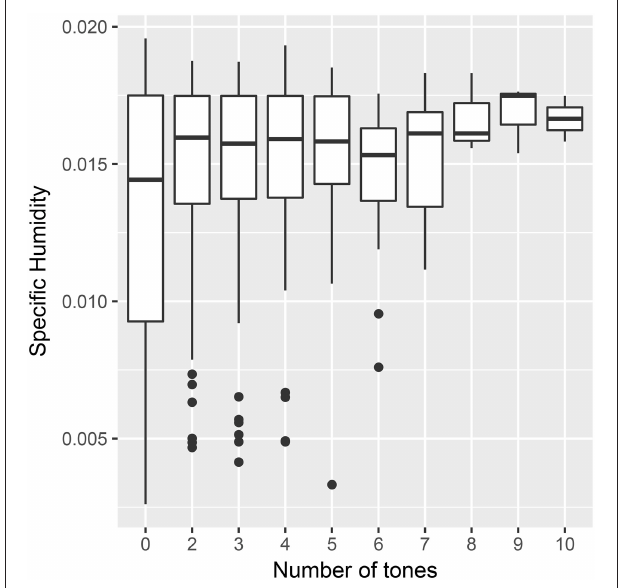
FIGURE 4 | Mean specific humidity by the number of tones in a language from the PHOIBLE database.